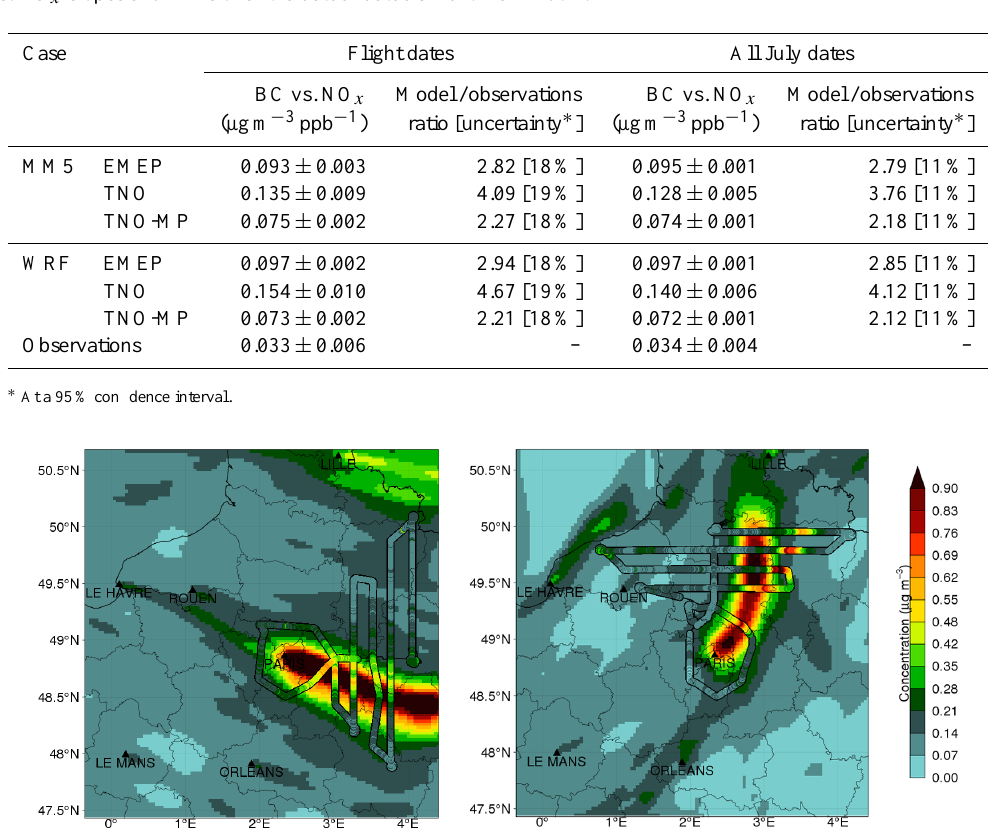
Table 2. BC vs. NO x slopes and EEFs over the 05:00–08:00UTC time window.